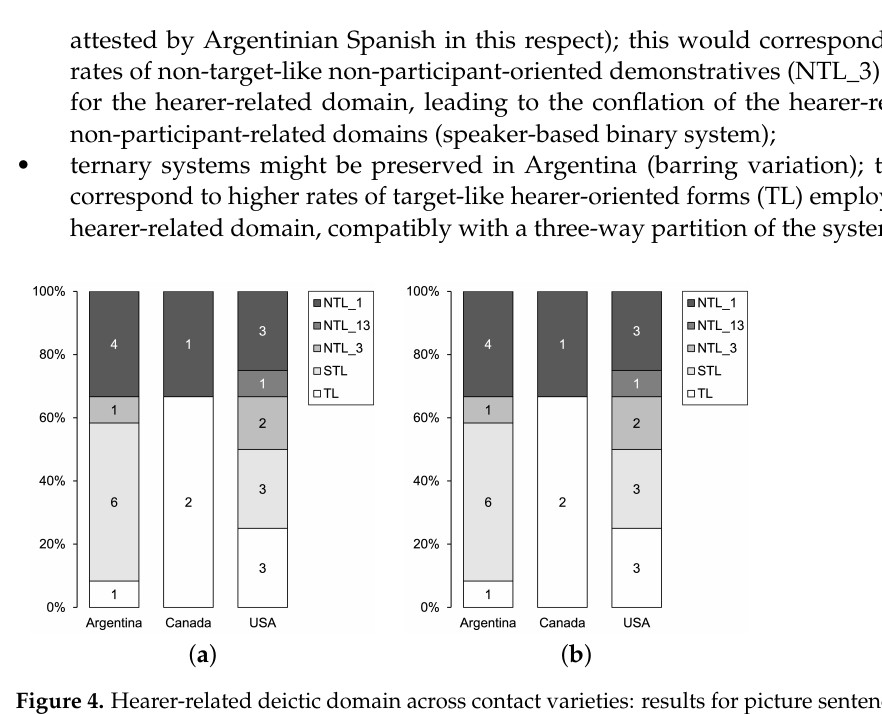
Figure 4. Hearer-related deictic domain across contact varieties: results for picture sentence matching task ( a ) and semi-guided production ( b